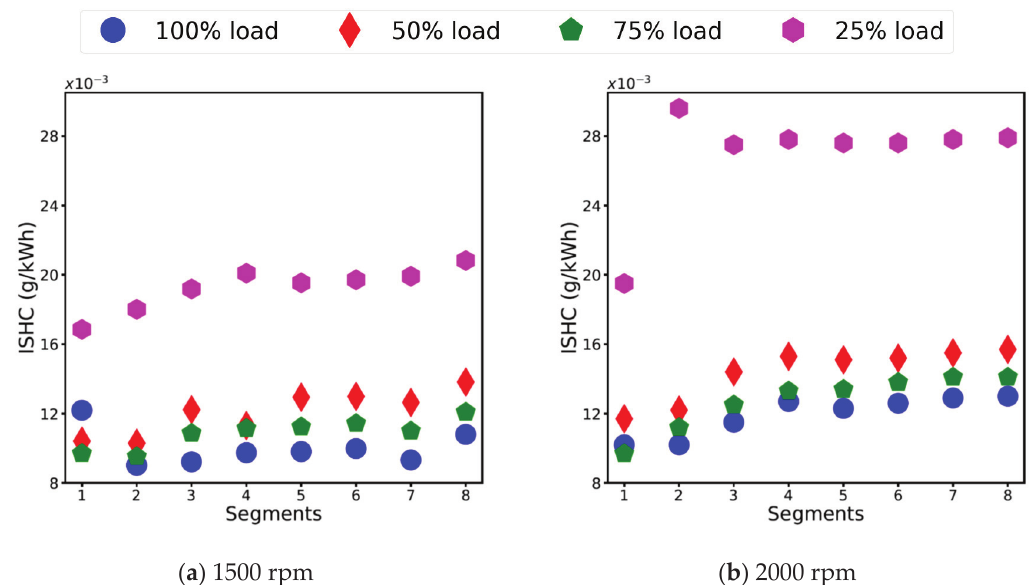
Figure 16. HC emissions (g/kWh) at each load in each segment at ( a ) 1500 and ( b ) 2000 rpm. The blue circle represents 100% load, the red diamond 50% load, the green pentagon 75% load and the pink hexagon 25% load.